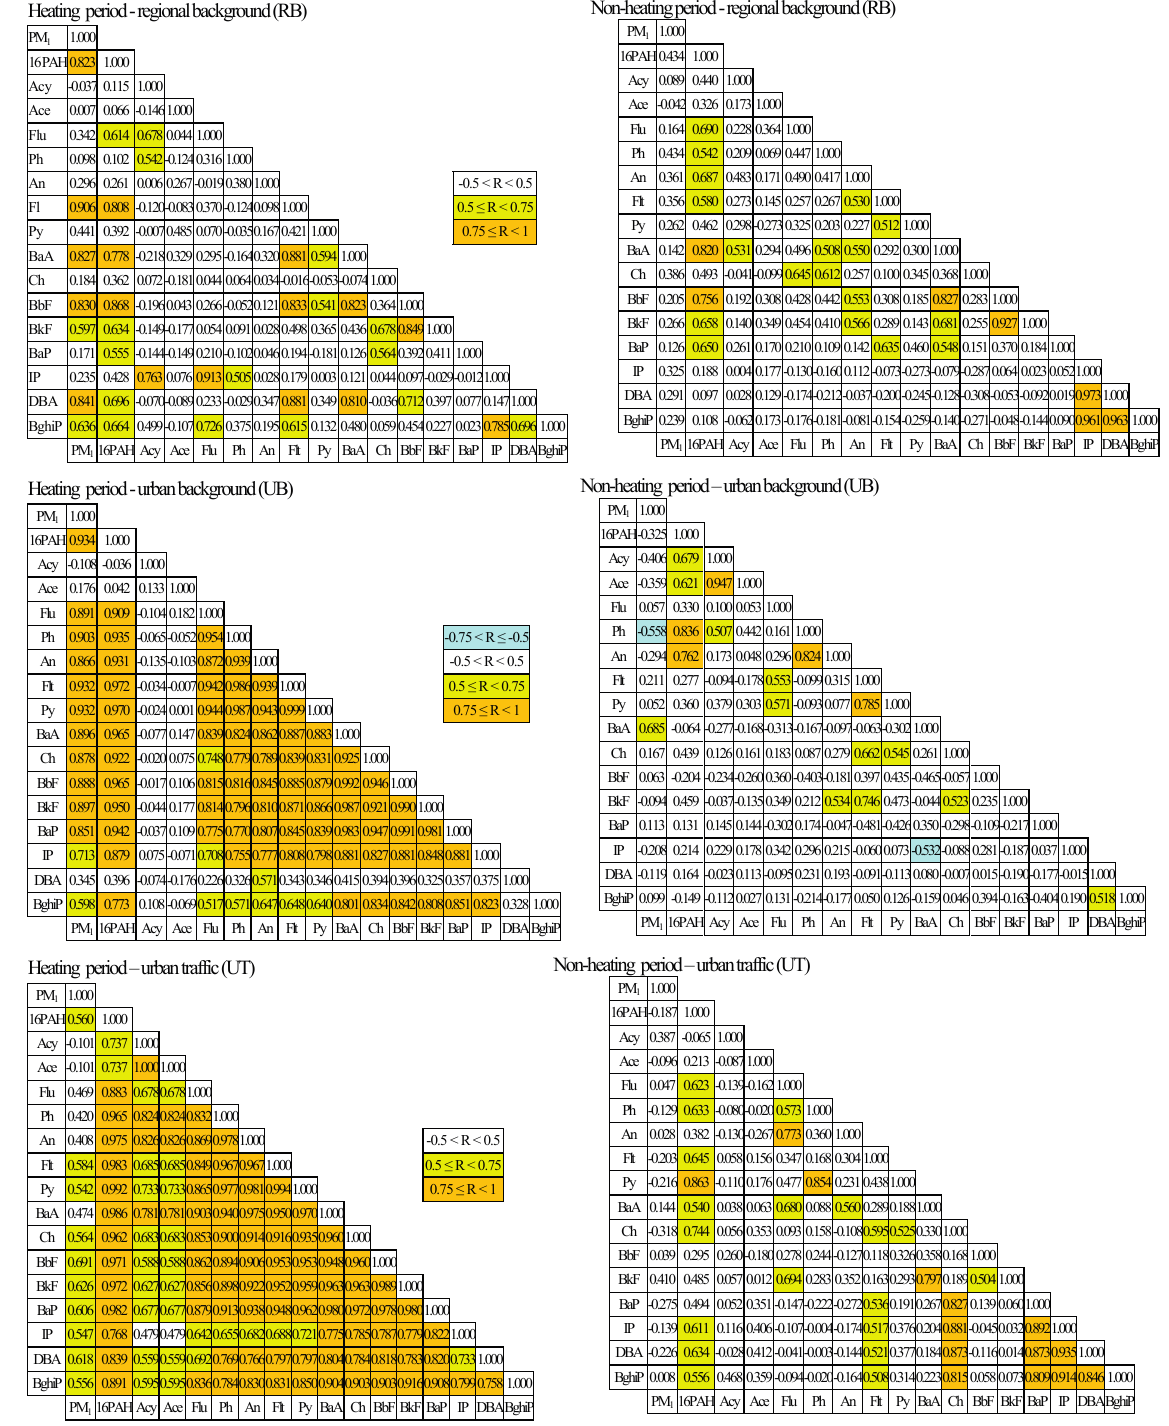
Figure 5. Correlation matrices for 24-h concentrations of PM1, sum of 16 PAHs and particular PAHs in two averaging periods for three locations in Silesia